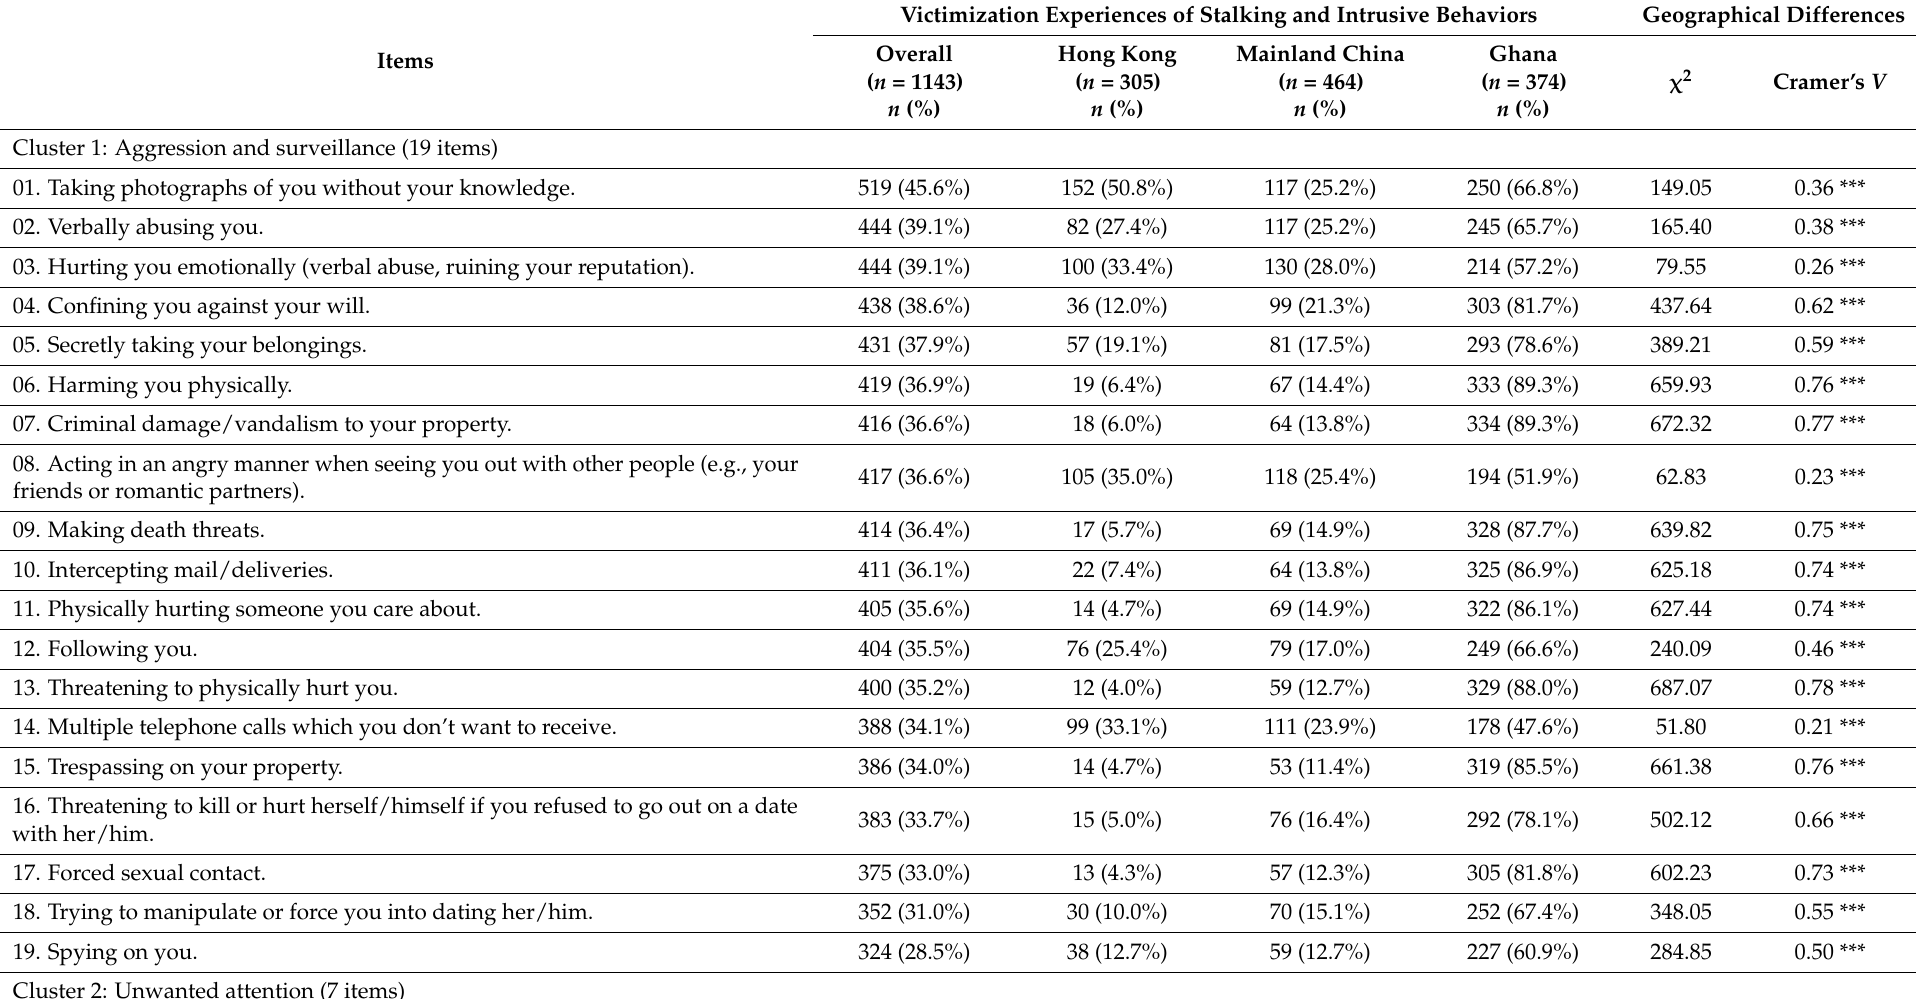
Table 2. Geographical distribution of victimization experiences of stalking and intrusive behaviors ( n = 1143).